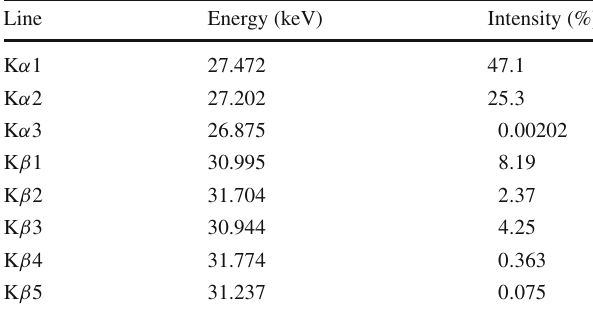
Table 2 Main Te X-ray emission lines. Data from [23]